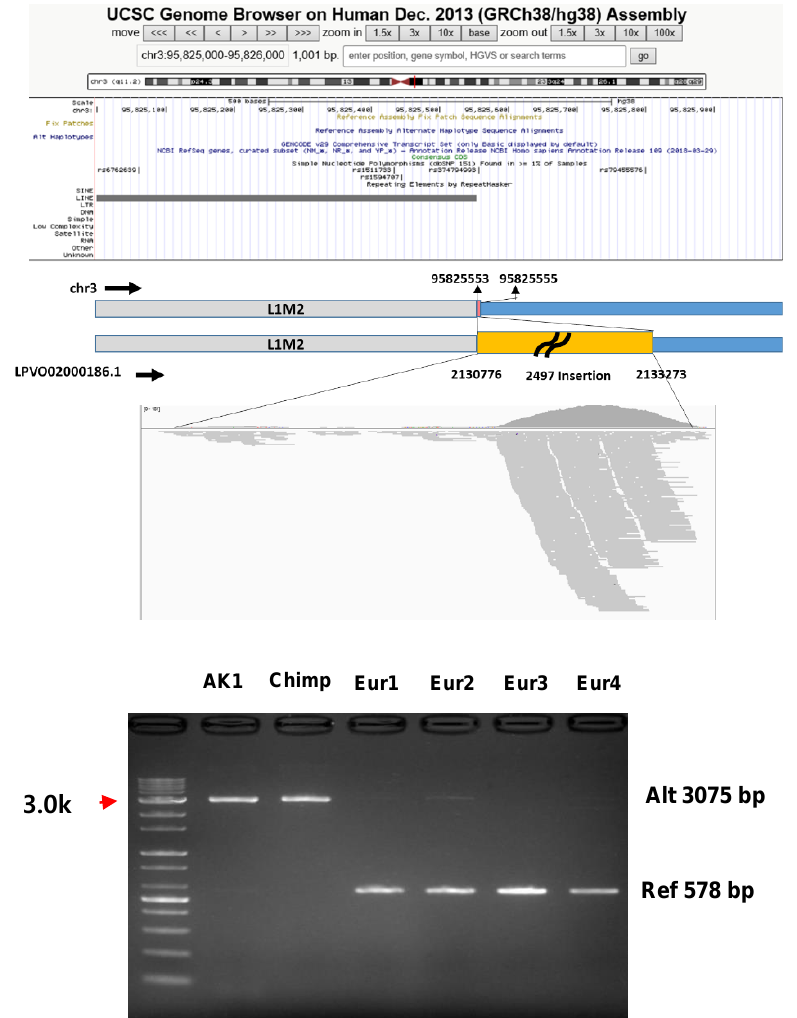
Figure 3. The example of globally missing regions on GRCh38 investigated with UCSC Genome browser and the experimental verification of the existence of the regions. The region (Group 1) with a high depth with 7 or more samples was discovered in the inserted sequences (yellow block). The G1-26 region (Insertion into chr3:95,825,553–95,825,555) was near L1M2. The yellow block is the estimated insertion against GRCh38 on the chain file. The grey blocks are repetitive sequences. The pink block is the sequence only on the GRCh38 genome. Chimp, chimpanzee; Eur, European.